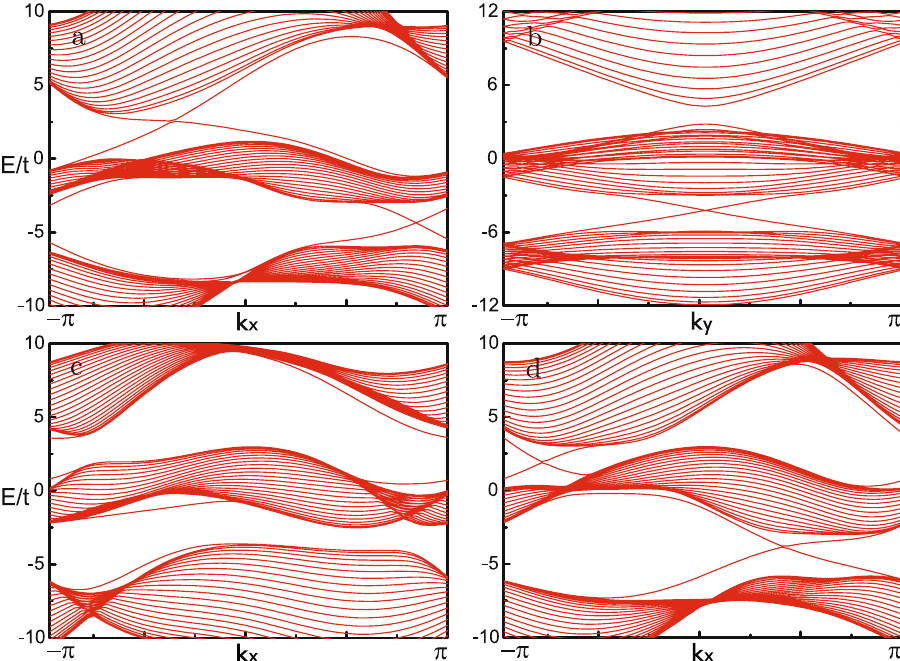
Figure 3. Energy spectra E as a function of quasi-momentum k . ( a , b ) Phase transition {1, 2, 1} driven by changes of detuning (